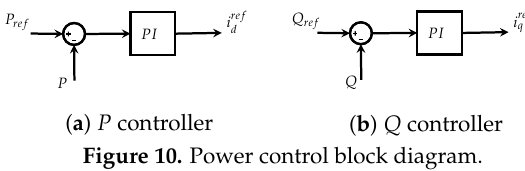
Figure 10. Power control block